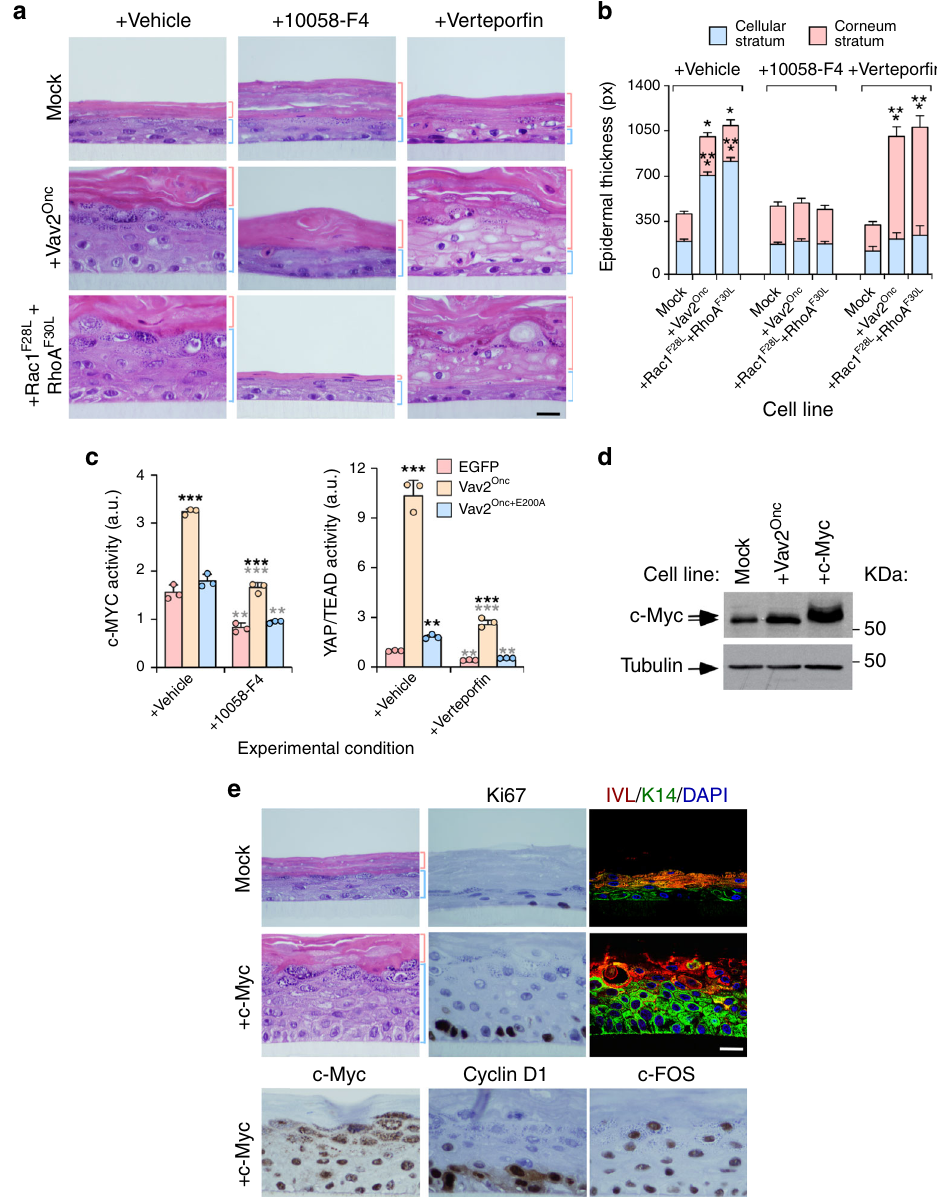
Fig. 7 Vav2 Onc -driven hyperplasia is c-MYC- and YAP-dependent. a Histological sections of 3D organotypic cultures of human keratinocytes expressing the indicated proteins (left) that have been treated with the inhibitors shown on top. Scale bar, 10 μ m ( n = 3 independent cultures). b Thickness of the cellular and corneum strata using data from a . * P = 0.012 (Vav2 Onc vehicle, stratum corneum), 0.037 (Rac1 F28L + RhoA F30L vehicle, stratum corneum); *** P < 0.0001 (all other tests) (ANOVA and Dunnett ’ s multiple comparison test, n = 3 independent cultures). c Demonstration that the transcriptional activity of c-MYC and TEAD is inhibited by MYC (10058-F4) and YAP/TEAD interaction (Vertepor fi n) inhibitors, respectively. Black and gray stars indicate the P value of the indicated experimental values when compared to EGFP-transfected and vehicle-treated cells, respectively. ** P = 0.003 (EGFP, 100058-F4, MYC activity), 0.002 (Vav2 Onc + E200A , 100058-F4, MYC activity), 0.001 (Vav2 Onc + E200A , vehicle, YAP/TEAD activity), 0.001 (EGFP, Vertepor fi n, YAP/TEAD activity), 0.002 (Vav2 Onc + E200A , Vertepor fi n, YAP/TEAD activity); ***, P < 0.0001 (all other tests) (ANOVA and Tukey ’ s HSD test, n = 3 independent experiments). d Expression of endogenous and ectopic c-Myc in indicated cell lines. Tubulin was used as loading control (bottom). n = 3 independent experiments. e Staining of indicated human keratinocytes (left) with hematoxylin-eosin (left and middle two rows of panels) and antibodies to Ki67 (two top middle panels), IVL (two right panels on top, red color), K14 (two right panels on top, green color), ectopically expressed c-Myc (left bottom panel), endogenous Cyclin D1 (middle bottom panel) and endogenous c-FOS (right bottom panel). When indicated, some sections were counterstained with DAPI (two right panels on top. blue color). Scale bar, 10 μ m ( n = 3 independent cultures). In b and c , data represent the mean ± SEM. Source data for this fi gure are provided as a Source Data fi